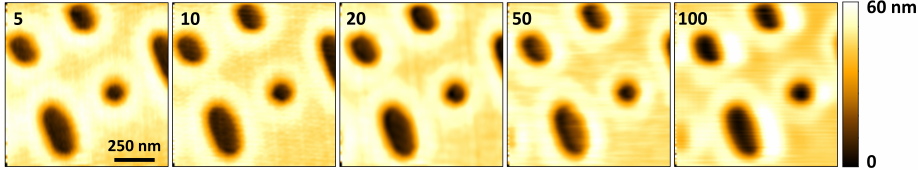
Figure 6. A 1 µ m × 1 µ m scan of Blu-ray disk data tracks consisting of 100 × 100 pixels. The line rate, in Hz, is indicated in the top left corner of each